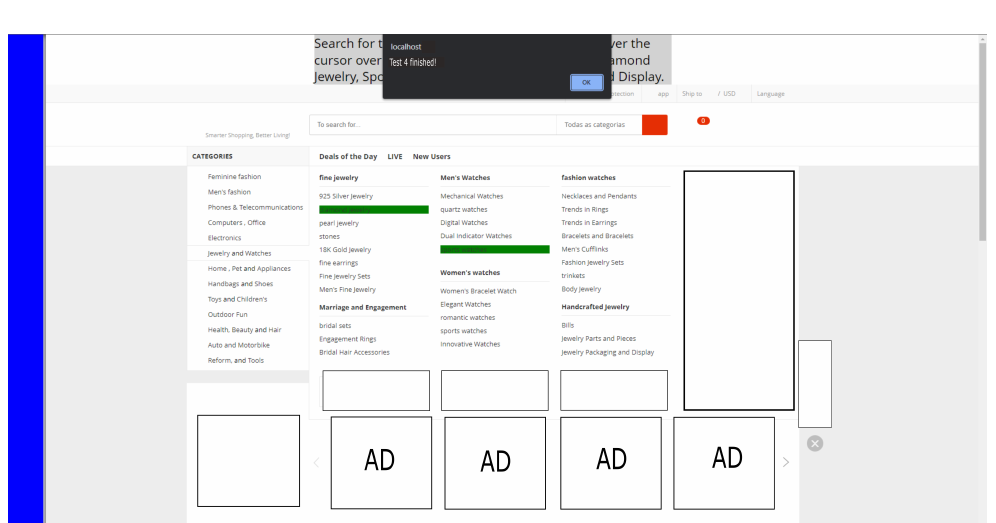
Figure 14. Final state of the task in scenario